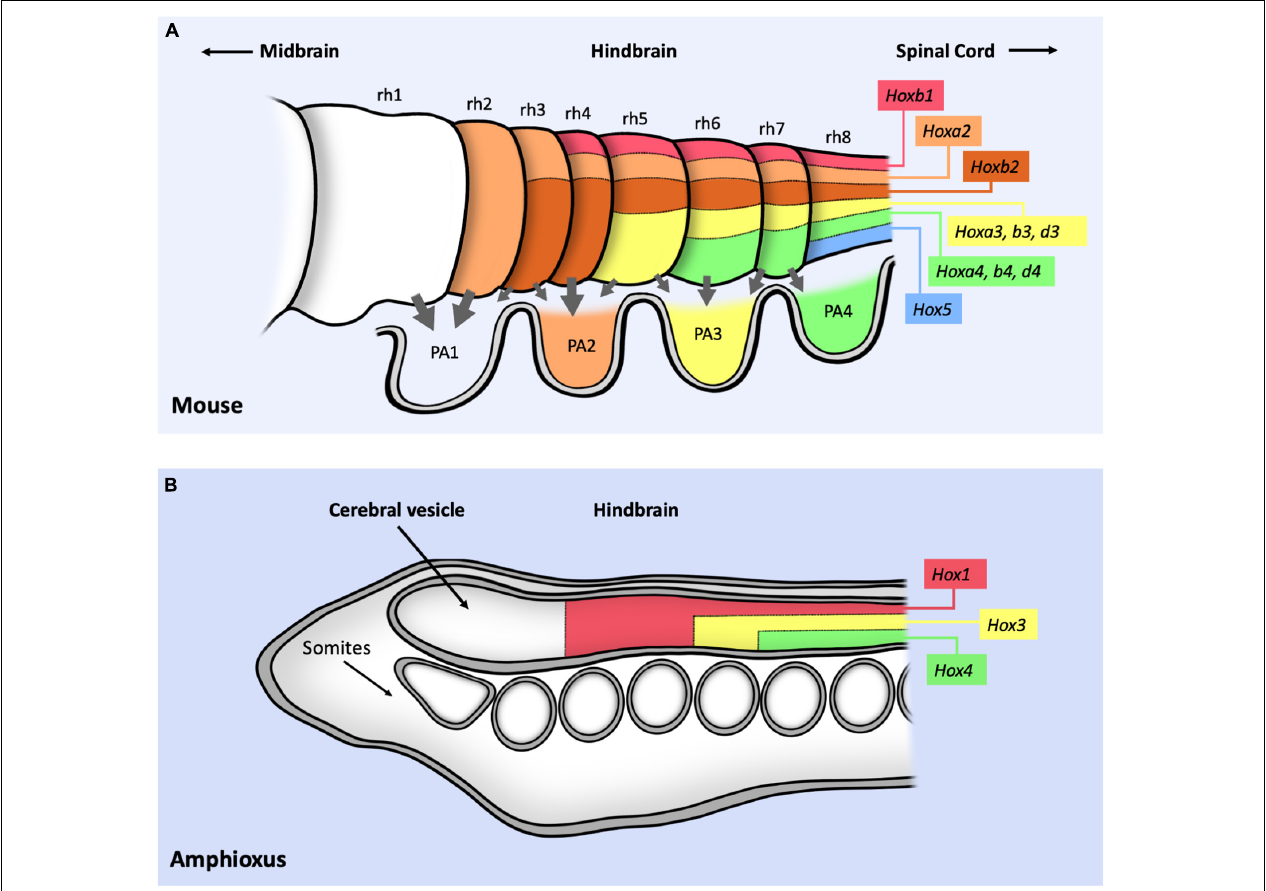
FIGURE 3 | Schematic representation of Hox expression in the cephalic mouse and Amphioxus central nervous systems. (A) Summary of Hox1–5 expression in the hindbrain, labeling the position of the eight different rhombomeres (rh1–8). Gray arrows represent the migratory movement of the cranial neural crest cells toward the pharyngeal arches (PA1–4). PA are colored following the pharyngeal Hox code: no Hox proteins are expressed in PA1; HoxA2 and B2 proteins are expressed from PA2 to PA4; HoxA3, B3 and D3 from PA3 to PA4; HoxA4, B4, D4 and Hox5 in PA4. (B) Expression of three Hox genes in the anterior part of the Amphioxus CNS. Note that the conserved relative position of Hox gene expression with respect to the mouse CNS suggest a positional correlation of both nervous systems despite the lack of rhombomeres or neural crest cells in Amphioxus . In both panels, information only concerns antero-posterior expression and not dorso-ventral expression. Figure based on data from references (Holland et al., 2008; Philippidou and Dasen, 2013; Parker et al.,